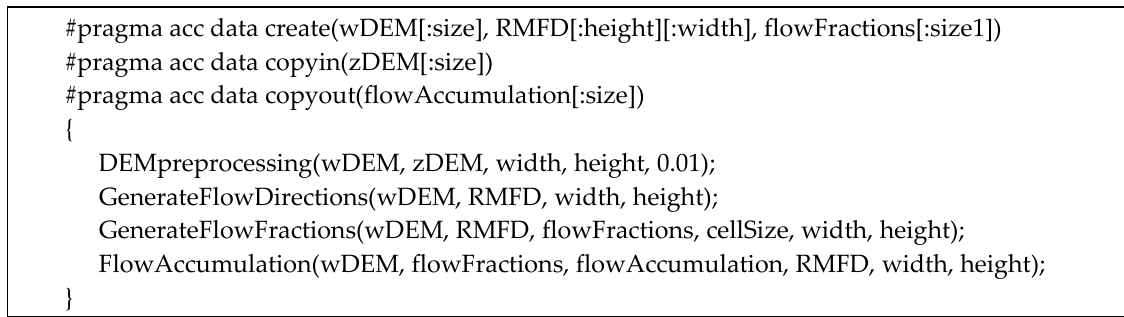
Figure 6. OpenACC parallel solution.